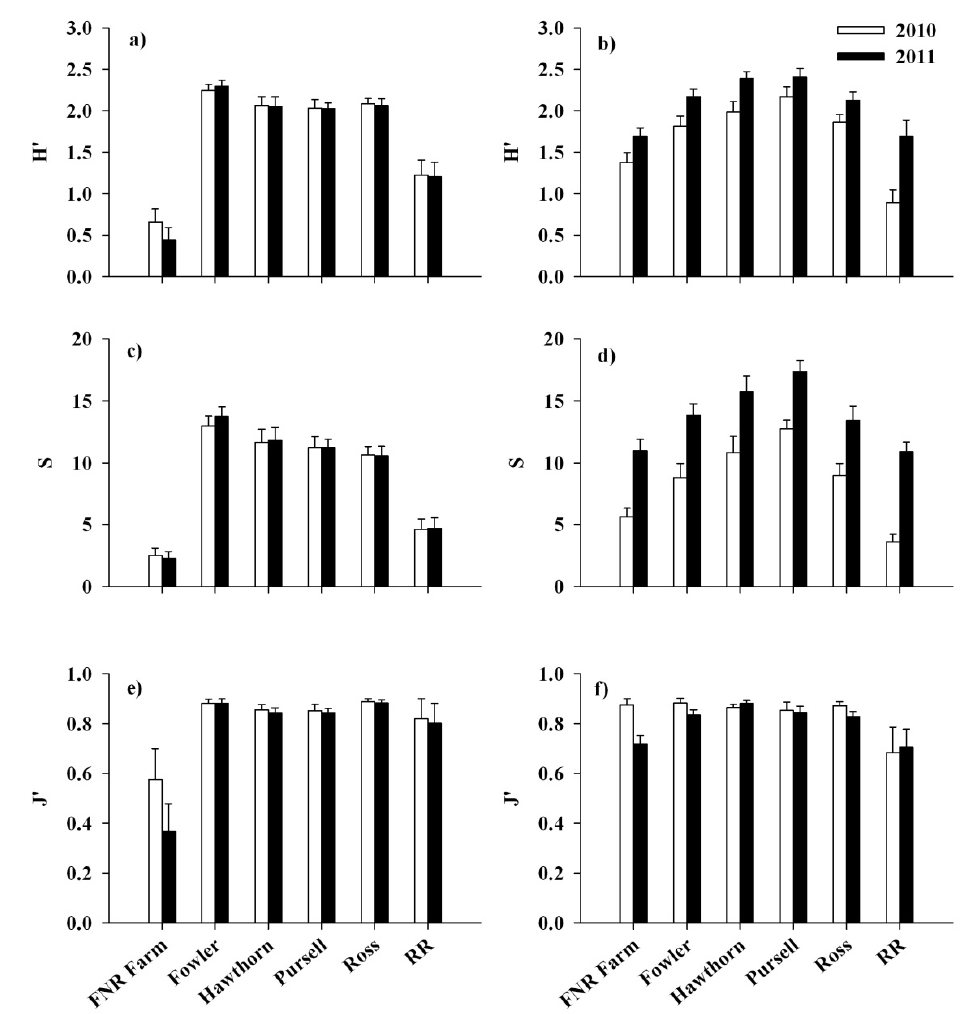
Figure 4. Mean Shannon’s Diversity Index (H') in reference areas ( a ) and removal areas ( b ); mean taxonomic richness (S) in reference areas ( c ) and removal areas ( d ); and mean Pielou’s Evenness Index (J') in reference areas ( e ) and removal areas ( f ) during the summer seasons of 2010 and 2011 at six mixed-hardwood forests in central Indiana. Error bars are ± 1 SE. Indices were based on percent covers of all native herbaceous and woody taxa encountered during the